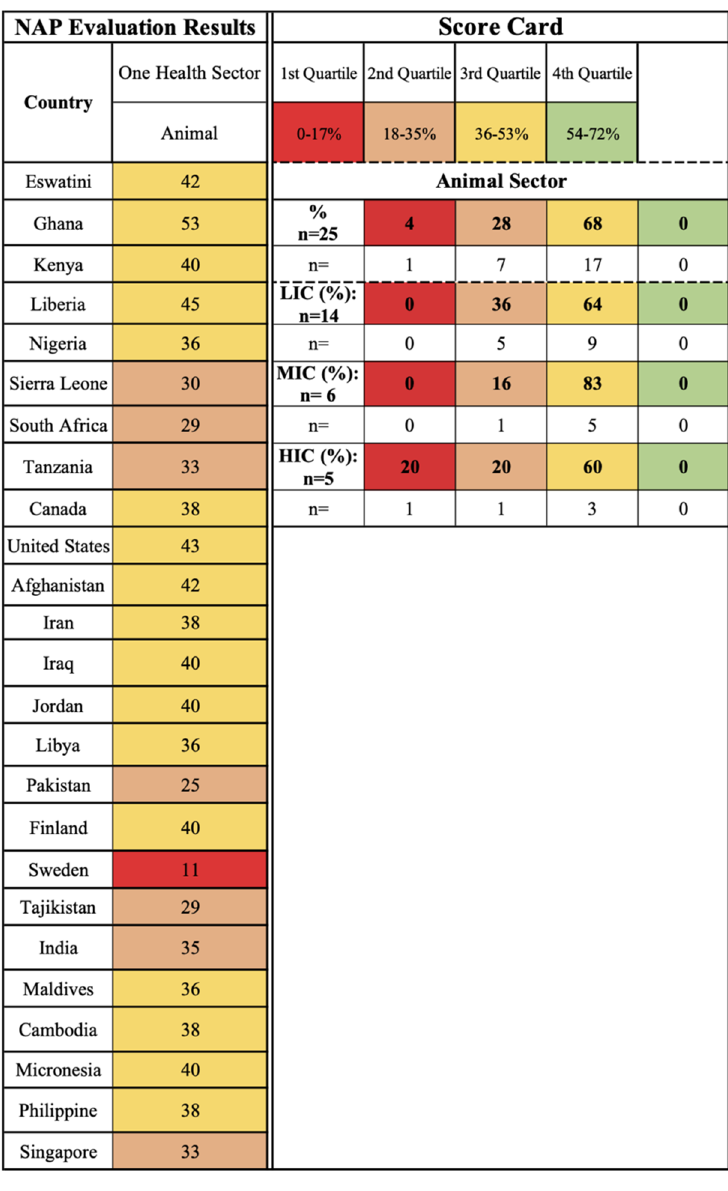
Figure 4. Animal One Health sector scorecard by country and income level. in plants) scorecard by country and income level.